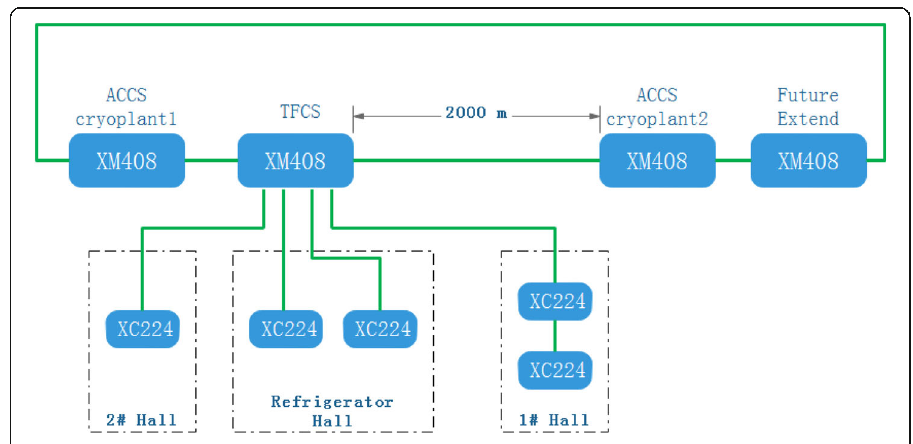
Fig. 3 Network topology of SHINE cryogenic control